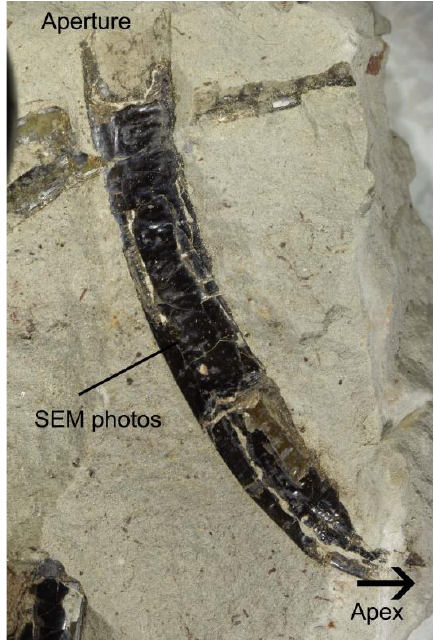
Figure 4. Periderm of Sphenothallus sp. from the Carboniferous of Russia. Location of SEM images indicated.